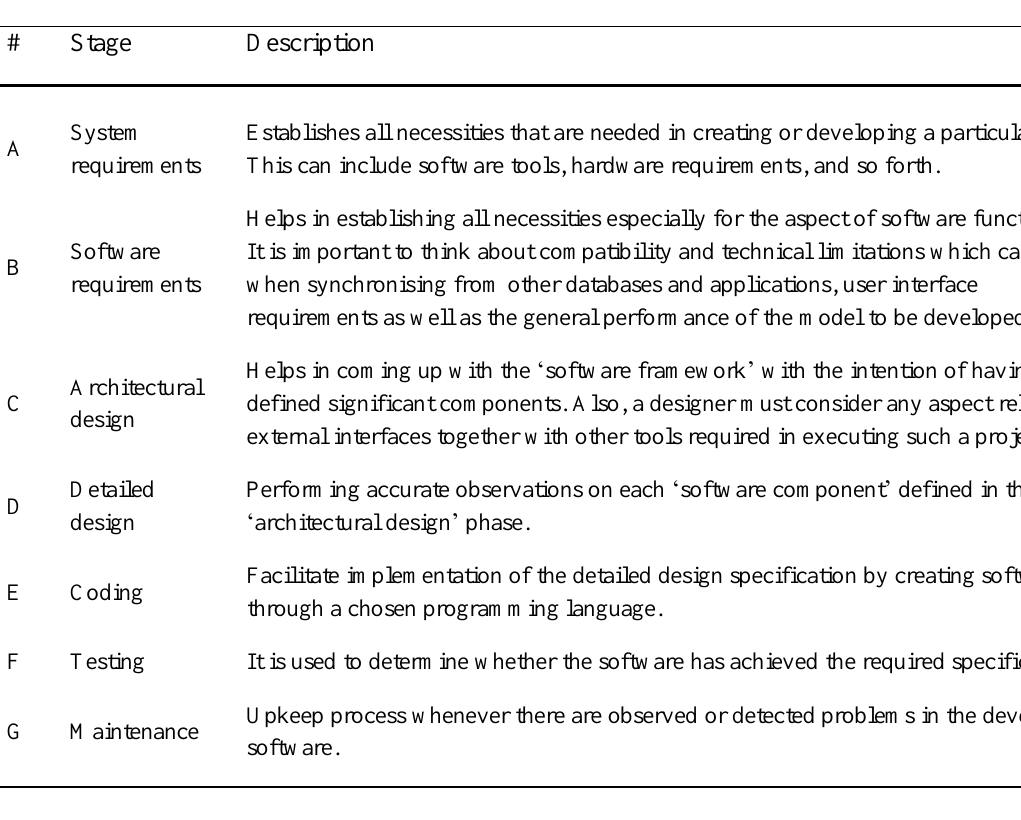
Table 2. The Waterfall Model